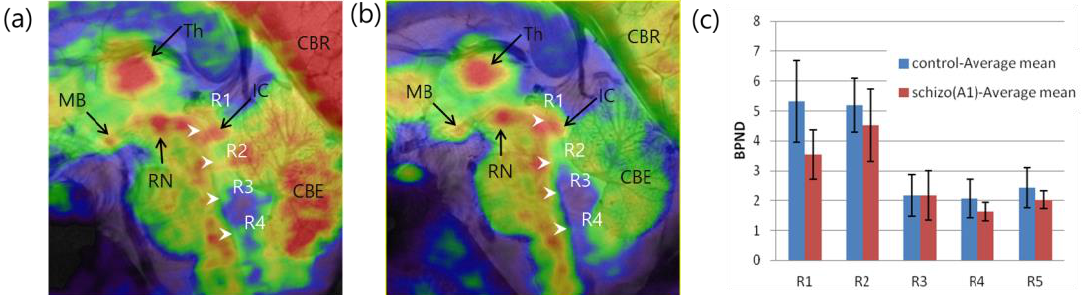
Figure 6. Raphe nuclei were identified in the brainstem by PET–MRI using ( a ) [ 18 F]FDG and ( b ) [ 11 C]DASB PET. ( c ) Group differences in the BP ND of the SERT of healthy controls and schizophrenic patients observed by PET–MRI. Reprinted with permission from Son et al., 2012, Elsevier [54]. Th; thalamus, MB; mammillary body, RN; red nucleus, IC; inferior colliculus, R1-R4; raphe nuclei, CBR; cerebral cortex, CBE; cerebellum, schizo(A1); patients with acute